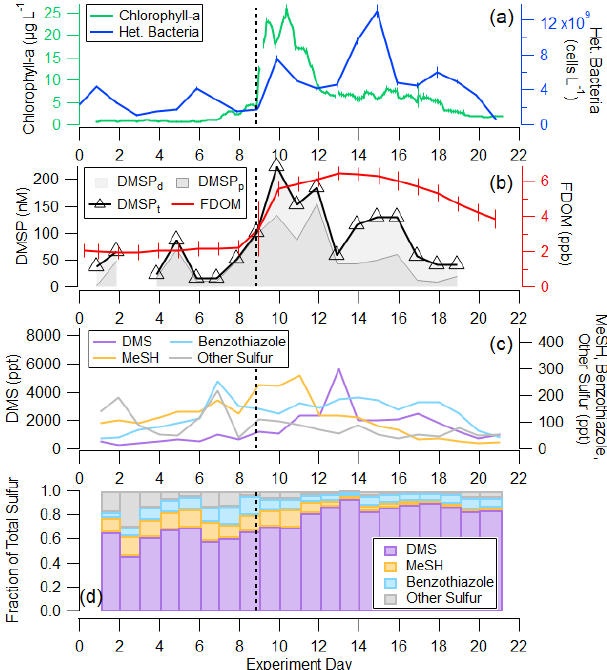
Figure 3. (a) Time series of (a) 2h average chlorophyll- a and daily heterotrophic bacteria concentrations in the wave channel; (b) daily DMSP t and FDOM; (c) DMS, MeSH, benzothiazole, and the sum of other detectable sulfur ions in the mass spectrum in absolute concentration; and (d) fractional contribution of DMS, MeSH, ben- zothiazole, and the sum of other detectable sulfur ions in the mass spectrum to the total measured gas-phase sulfur budget by the Vo- cus. Fractional contribution is calculated by mixing ratio. The wave channel was filled on day 0, and nutrients were added on days 2.2 and 3.2. The tank of productive seawater and more nutrients were added on day 8.9, shown by the vertical line. More details on these changes are recorded in Table